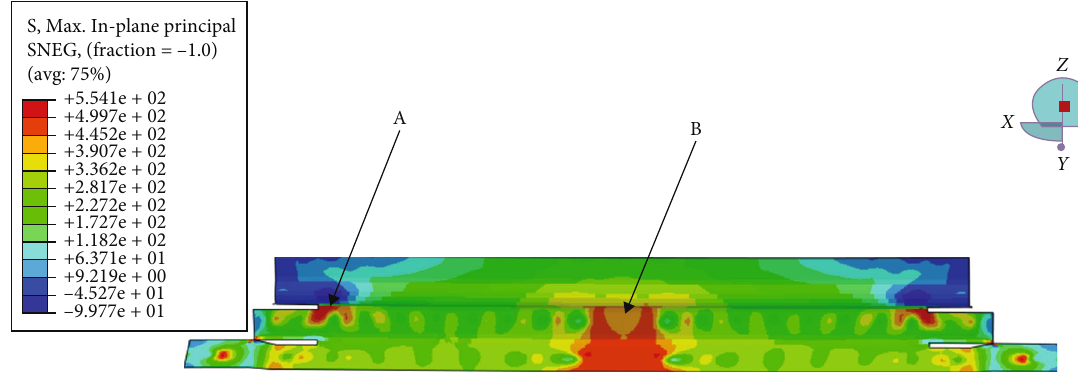
Figure 18: Standard analysis maximum in-plain principal stress in the upper repair panel (MPa).